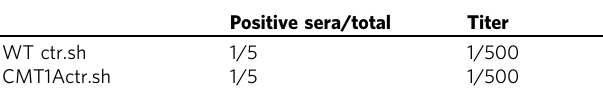
Table 4 AAV2/9 neutralizing factors titration three months after intra-nerve